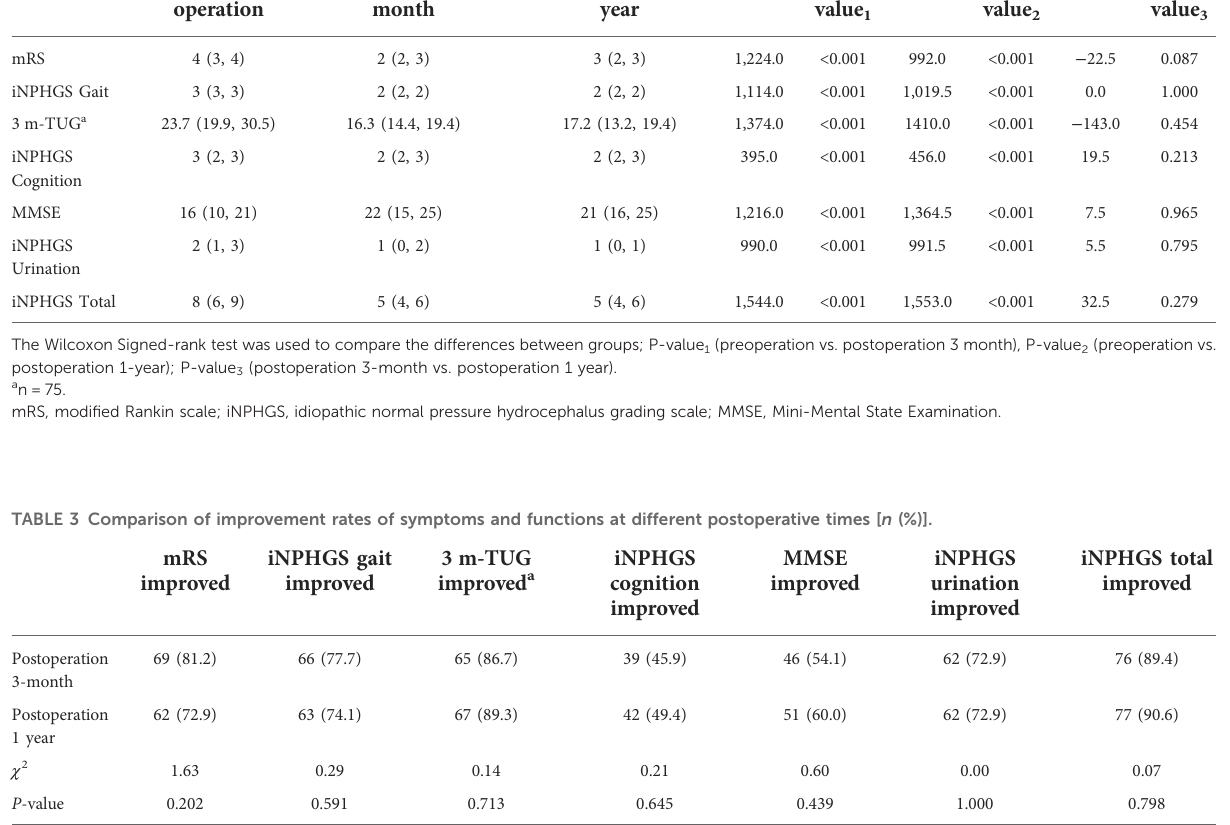
TABLE 2 Comparison of functional and symptomatic indicators of patients at different times [median (Q1, Q3)]. Pre operation